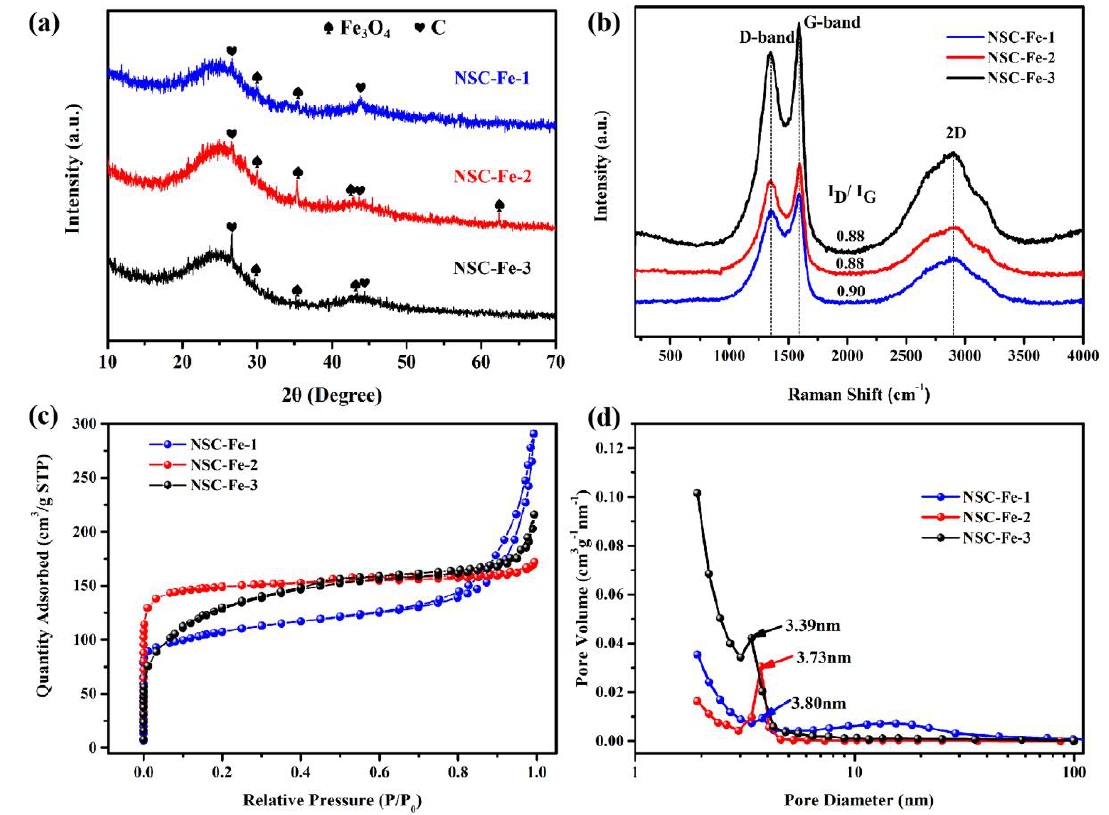
Figure 2. ( a ) XRD patterns of NSC-Fe- x , ( b ) Raman spectrum of NSC-Fe- x , ( c ) N 2 adsorption–desorption isotherms of NSC-Fe- x , and ( d ) pore size distributions of NSC-Fe- x .